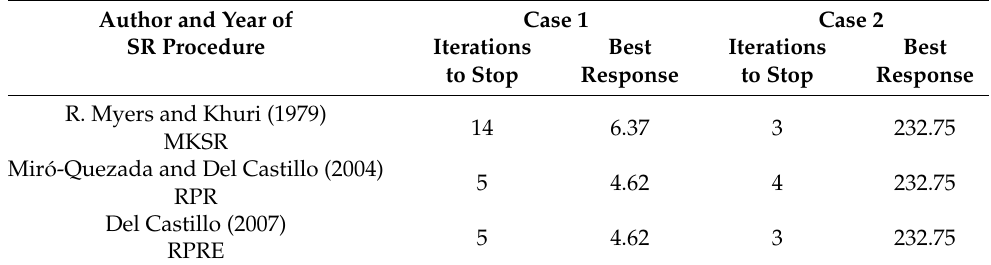
Table 12. Performance comparison for the three